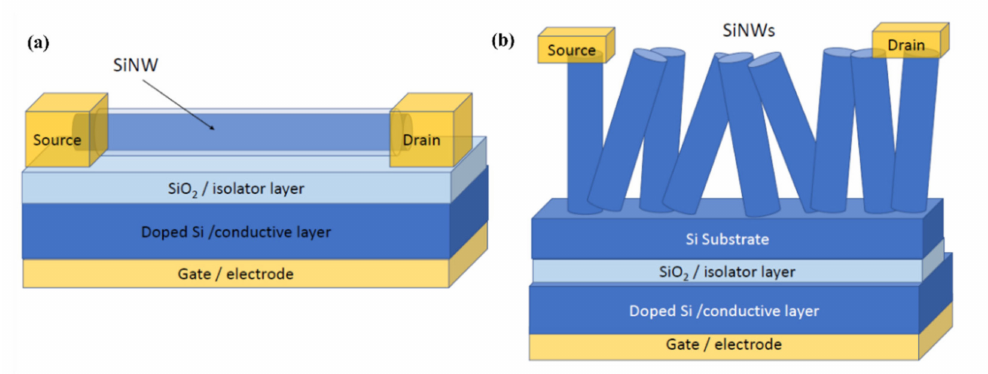
Figure6. SchematicofSiNW-FETasgassensorswhenNWsareformed( a )horizontallyand( b